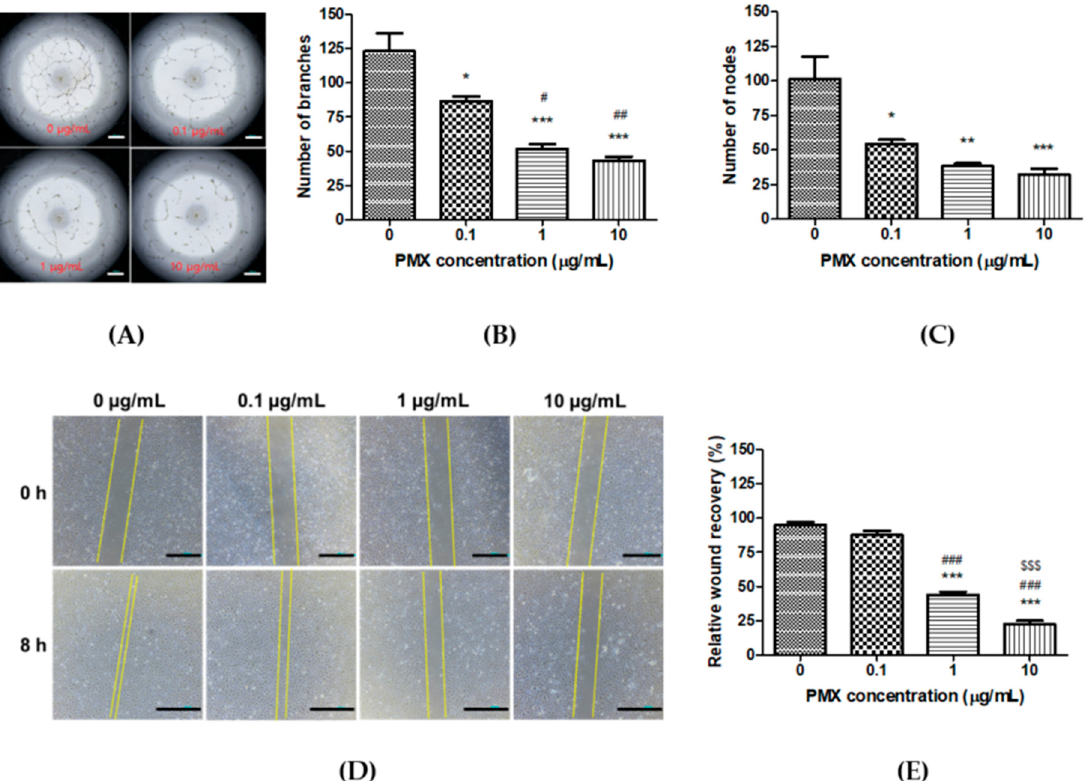
Figure 2. In vitro anti-angiogenic effect of PMX. ( A ) Dose-dependent effect of PMX on tube formation in HUVECs. Magnification 20×. Bar means 500 µm. ( B ) Quantitative image analysis of HUVEC tubes by ImageJ to determine the number of branches. ( C ) Quantitative image analysis of HUVEC tubes by ImageJ to determine the number of nodes formed. ( D ) Scratch wound recovery in HUVECs at 0 h and after 8 h of treatment with PMX at various concentrations (0, 0.1, 1, and 10 µg/mL). Magnification 40×. Bar means 1 mm. ( E ) Quantification of relative wound recovery. Data are presented as mean ± SEM ( n = 5 for each group). * p < 0.05, ** p < 0.01, *** p < 0.001 compared to the control. # p < 0.05, ## p < 0.01, ### p < 0.001 compared to 0.1 µg/mL PMX. $$$ p < 0.001 compared to 1 µg/mL PMX.